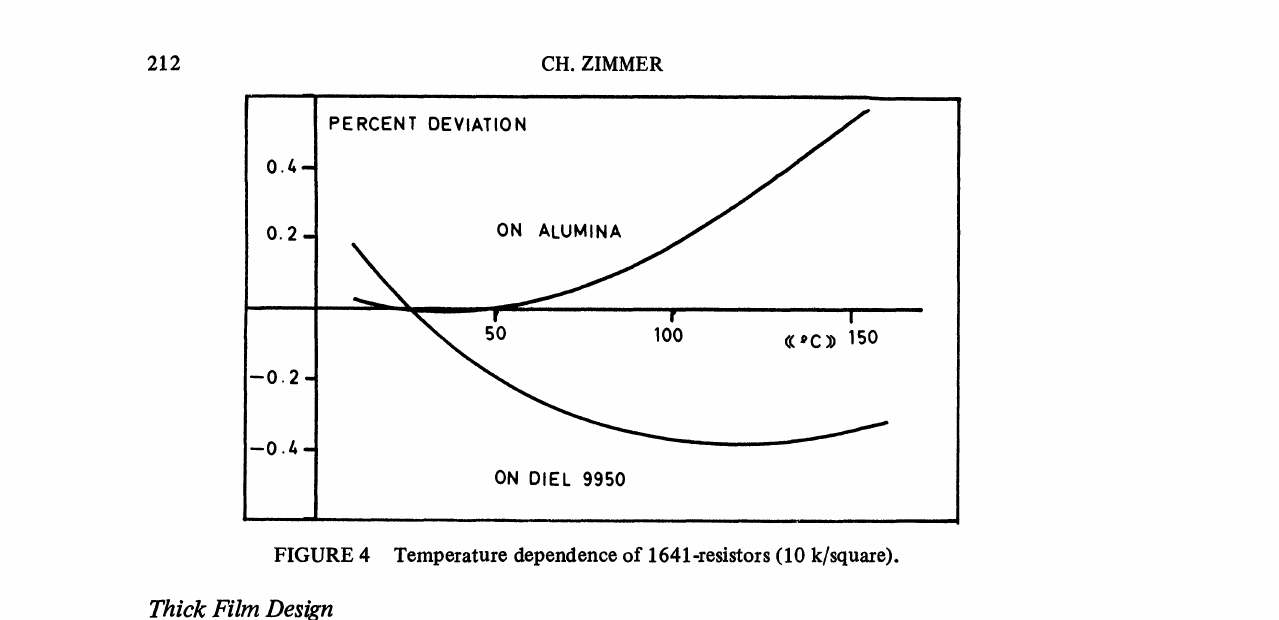
FIGURE 4 Temperature dependence of 1641-resistors (10